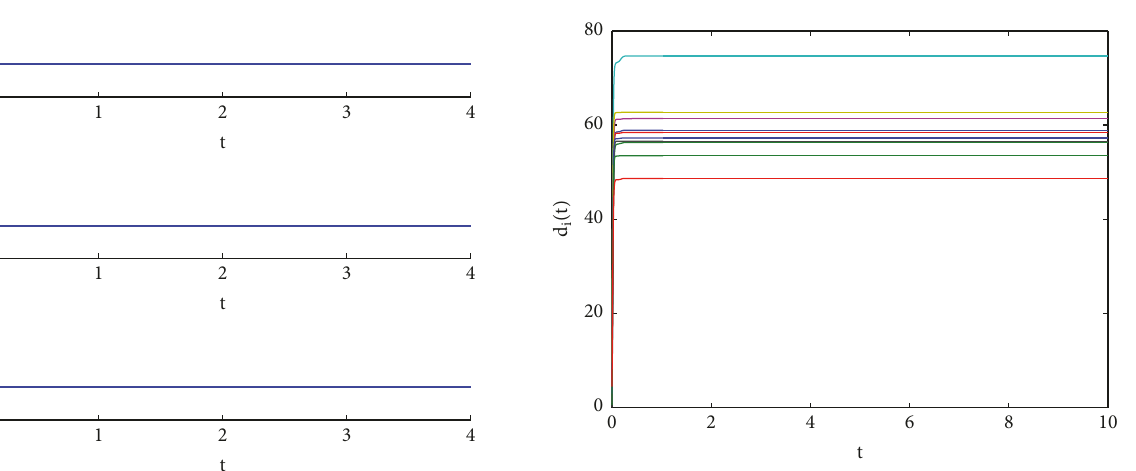
Figure 5: Finite-time mixed interlayer synchronization errors 𝑒 (𝑖 = 1,2,...,10) with 𝐴 = 𝐵 . 𝑖